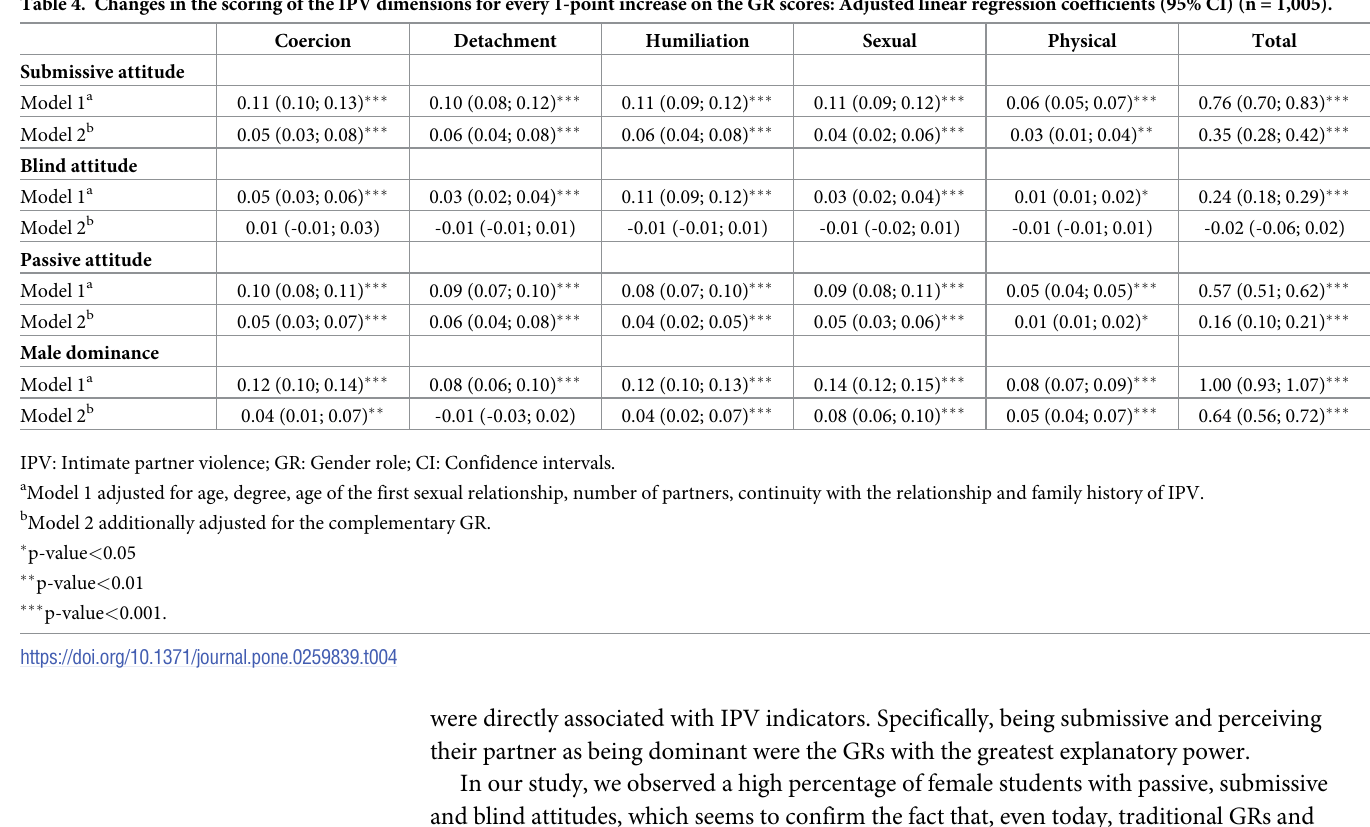
Table 4. Changes in the scoring of the IPV dimensions for every 1-point increase on the GR scores: Adjusted linear regression coefficients (95% CI) (n = 1,005).